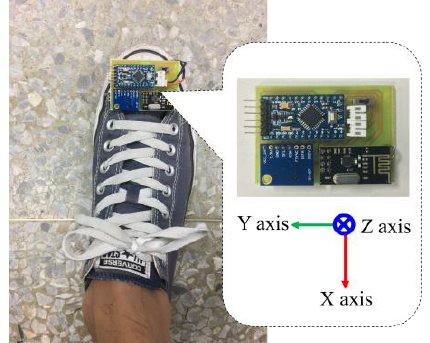
Figure 11. Wearable motion sensing device mounted on foot.